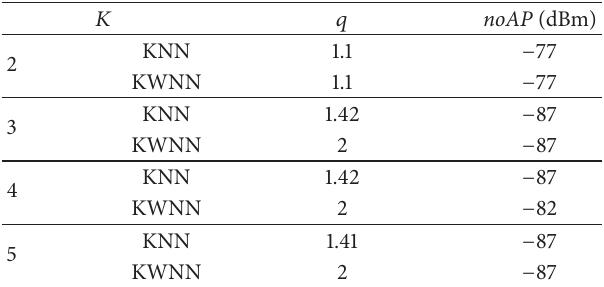
Table 3: Dependance of the optimal 𝑞 and 𝑛𝑜𝐴𝑃 values on the algorithm type and parameter 𝐾